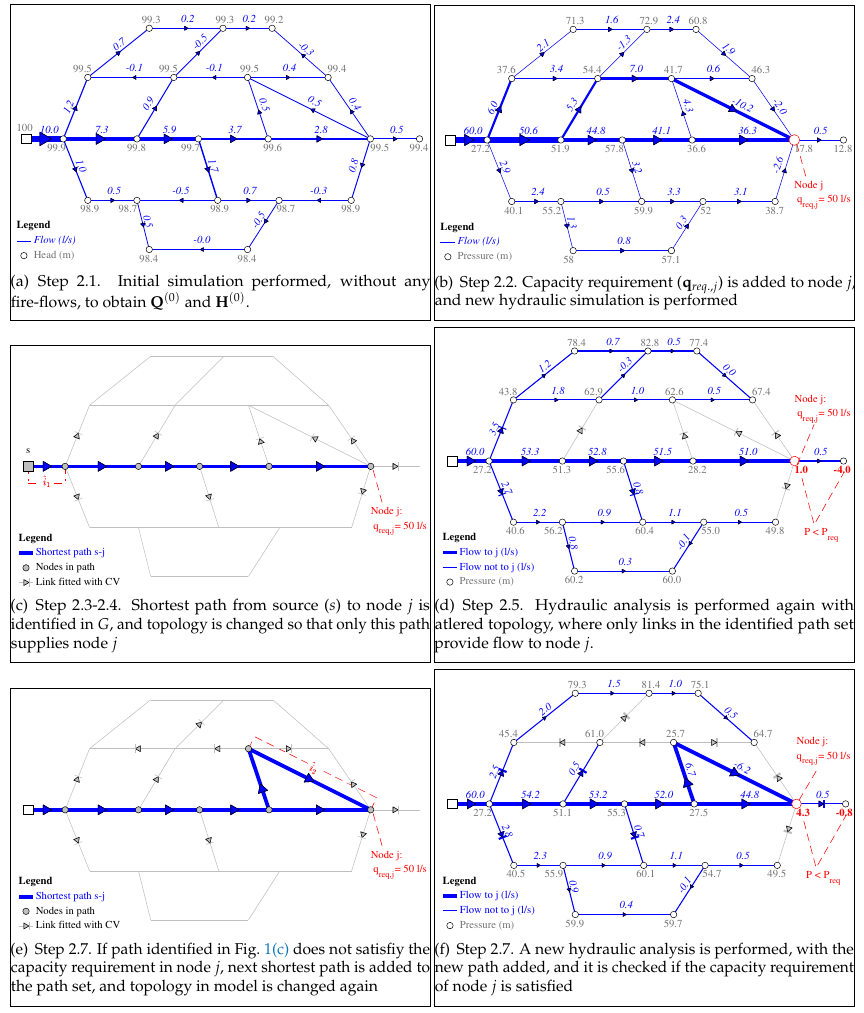
( 0 ) and H ( 0 ) . ( b ) Step 2.2. Figure A1 Figure A1. ( a ) Step 2.1. Initial simulation performed, without any fire-flows, to obtain Q